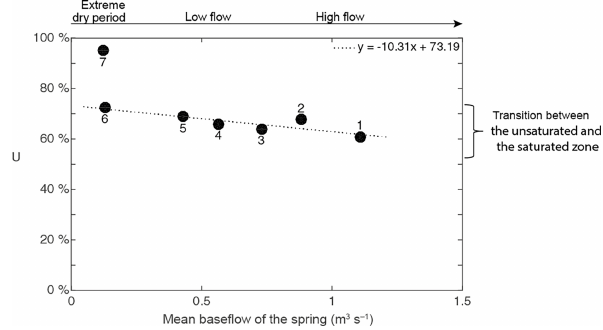
Figure 9. Representation of the limit estimation between unsatu- rated and saturated conduits along R2 as a function of the mean spring base flow. U calculation corresponding to the percentage of conduit length of R2 located within the unsaturated zone.